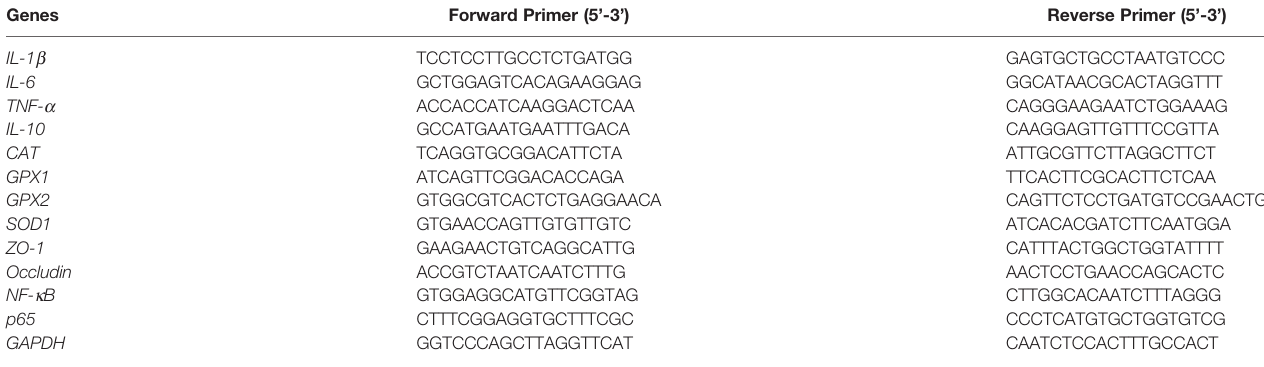
TABLE 1 | Primers used for qPCR